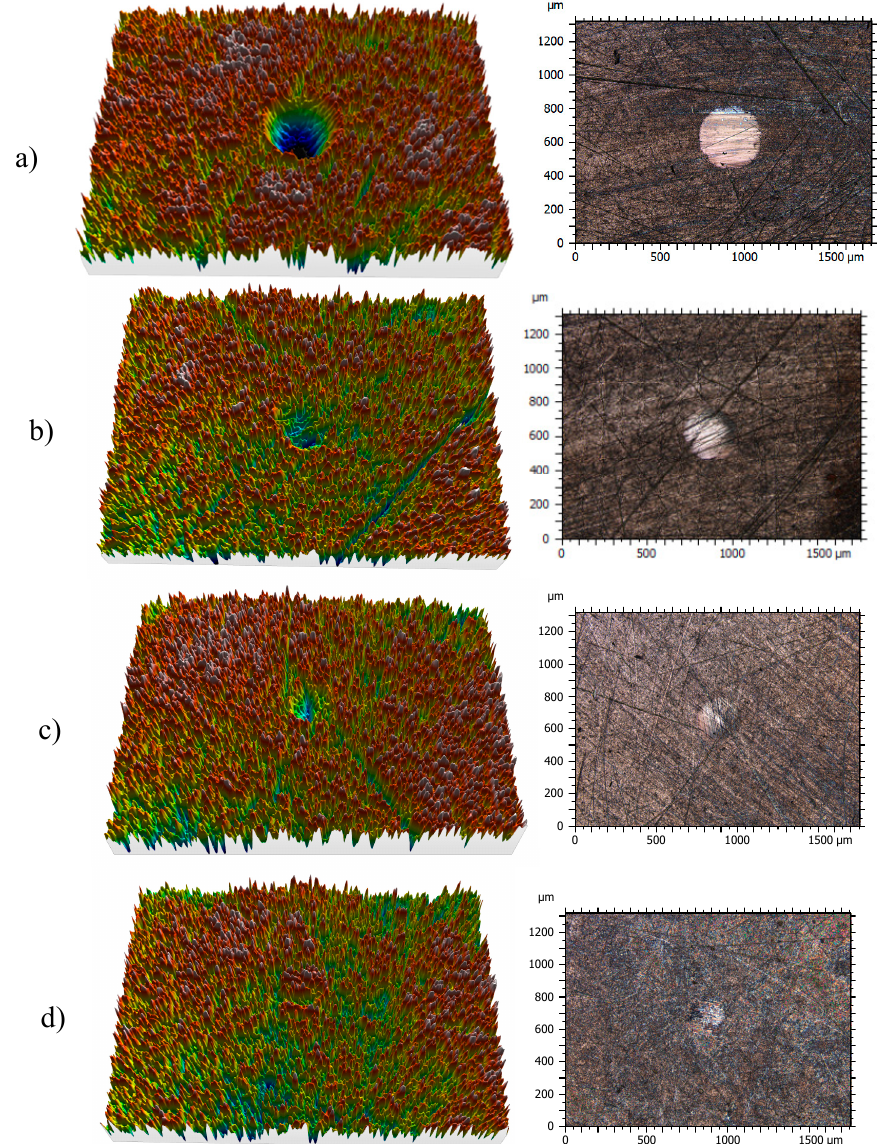
Figure 10. Three-dimensional (3D) profile (10 × ) and 2D images (10 × ) of the wear tracks of pins for: ( a ) TMPTO, ( b ) TMPTO + 0.015 wt% Fe 3 O 4 (6.3 nm), ( c ) TMPTO + 0.015 wt% Fe 3 O 4 (10 nm) and ( d ) TMPTO + 0.015 wt% Nd alloy (19 nm).